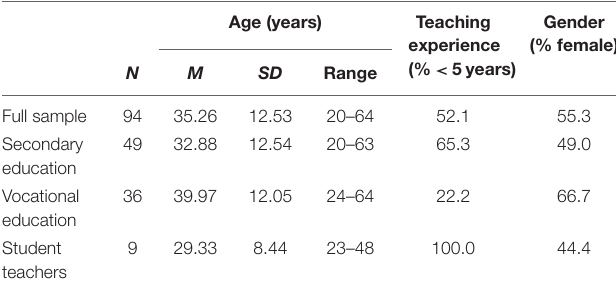
TABLE 1 | Teacher characteristics for the full sample and the three separate